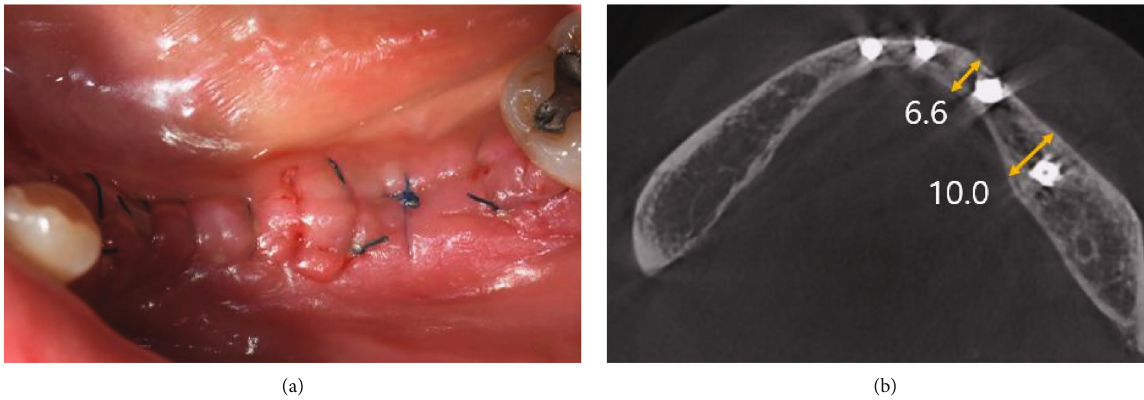
Figure 7: Postoperative intraoral (a) and radiograph views (b) (Case 2). The width of the alveolar bone was well expanded, and we can see that the implant had been placed in the right direction.